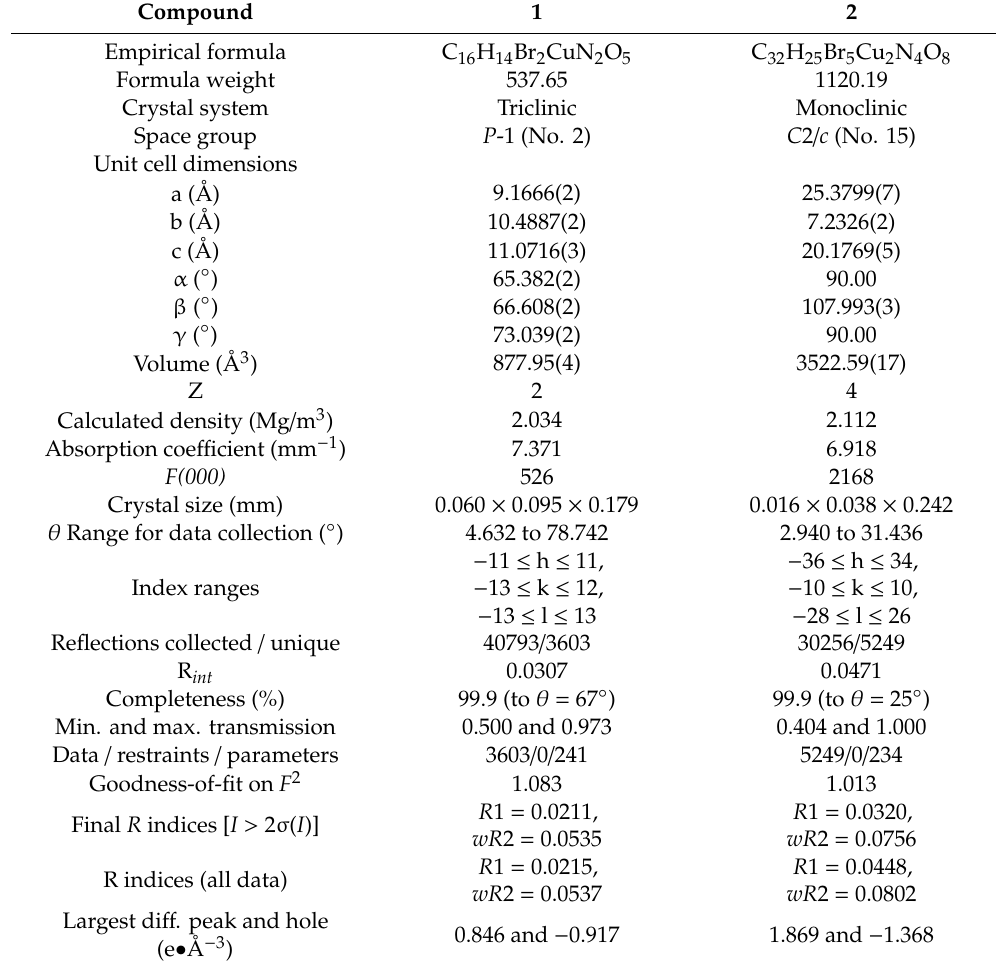
Table 3. Crystal data and structure refinement details for the studied